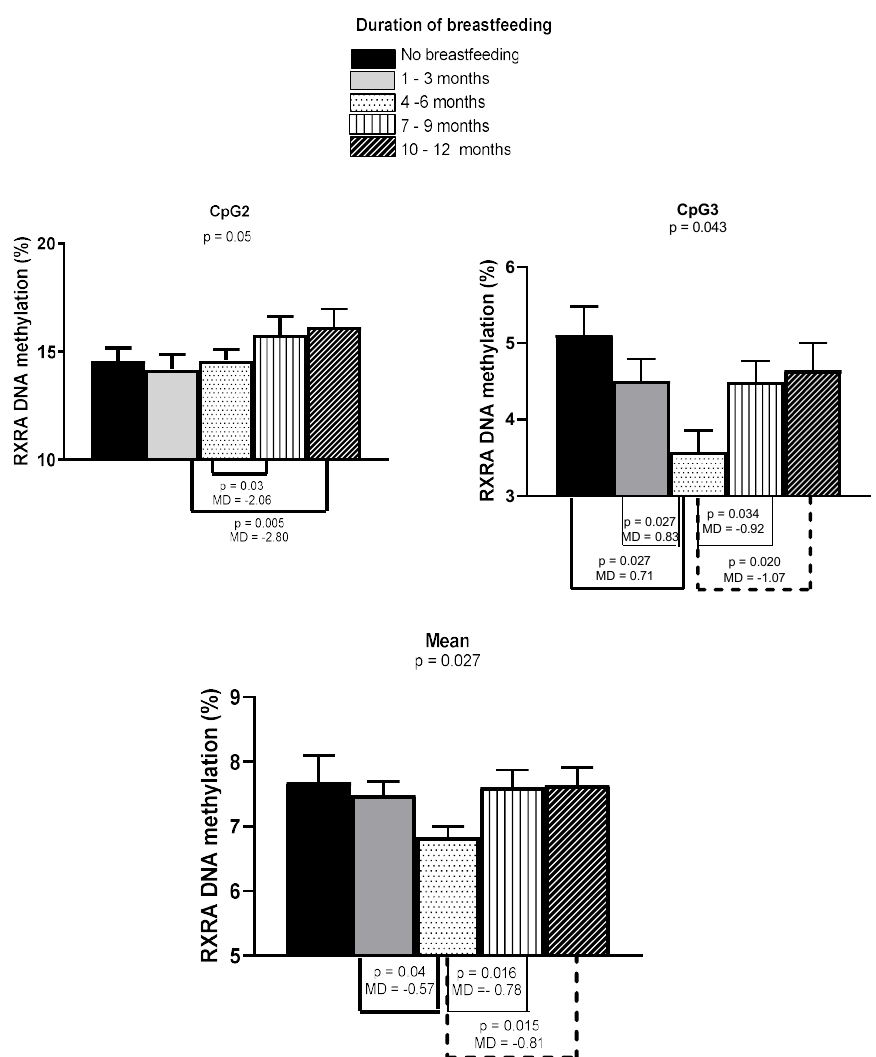
Figure 3. Buccal RXRA methylation by duration of breastfeeding. The bars represent the mean methylation values and standard errors of the mean of the 97 one-year-olds. The results are based on the duration (five categories) of maternal breastfeeding. The overall p -values (one-way ANOVA) and significant p -values with mean differences from post hoc tests are shown.